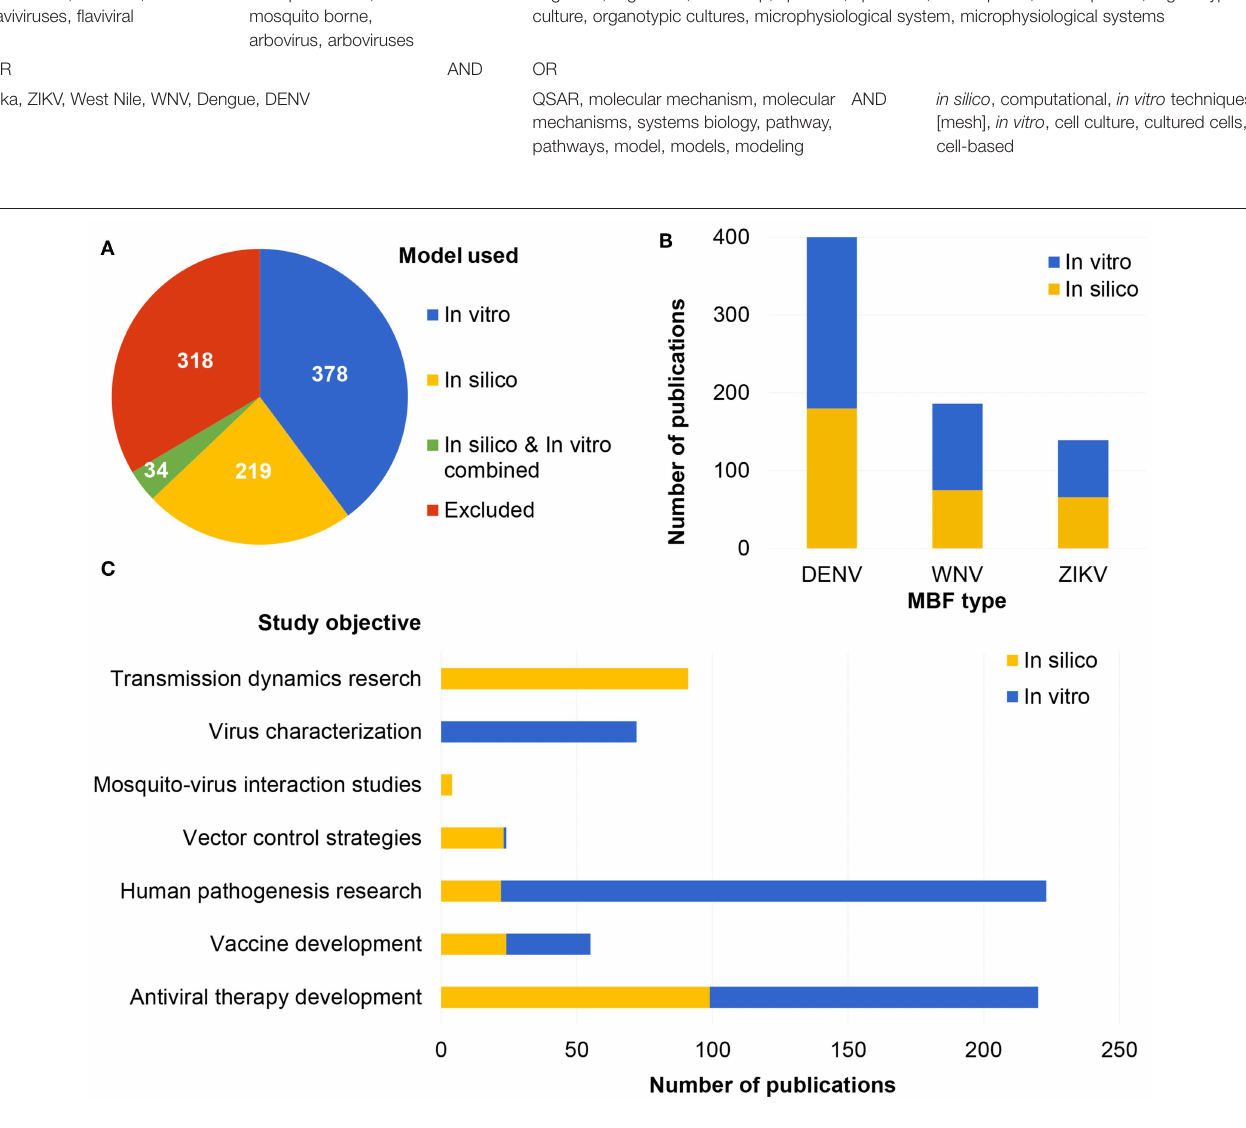
FIGURE 1 | Number of articles included and excluded with corresponding label for type of model used (A) , MBFs represented (B) , and study objectives (C) in the in vitro and in silico